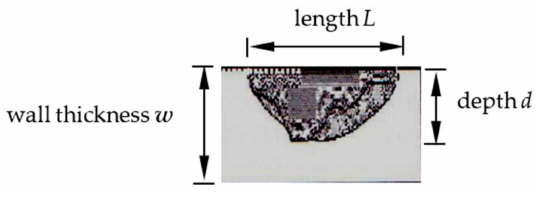
Figure 1. Local corrosion.